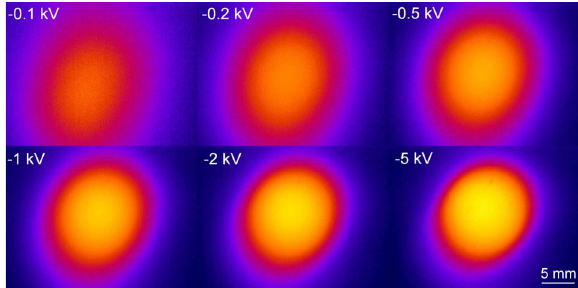
FIG. 9. Influence of the foil voltage on the image quality. See text for details.